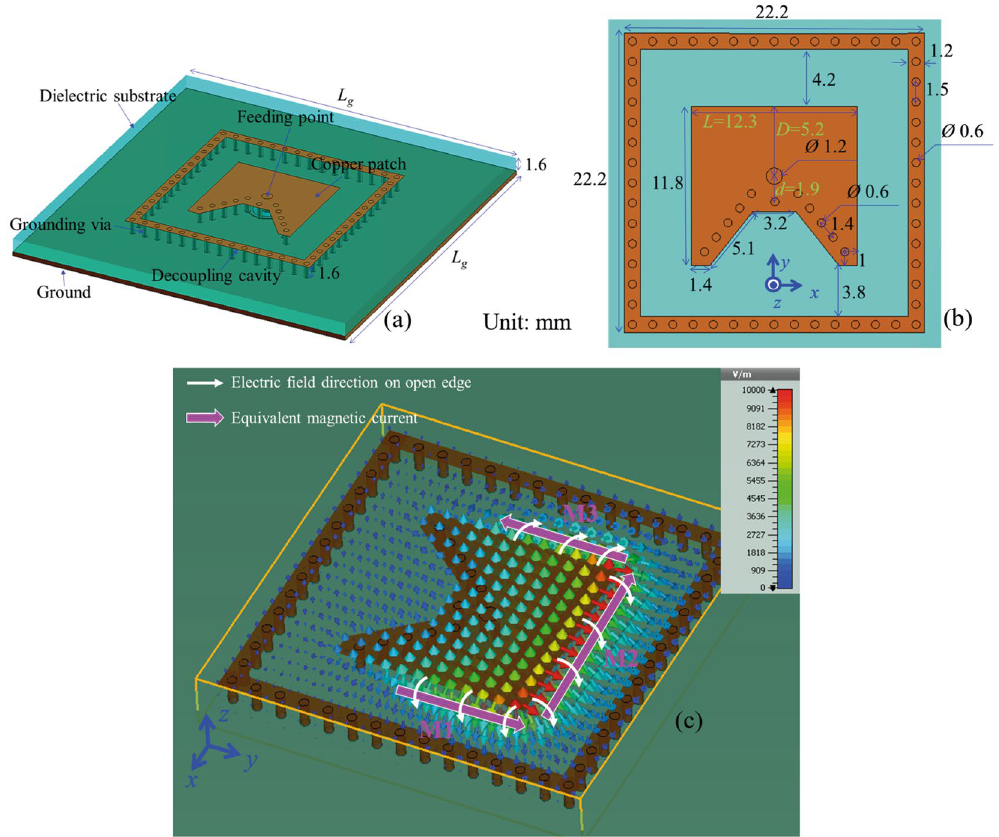
Figure 2. Geometry of the TMC antenna. ( a ) Perspective view and ( b ) partial enlarged detail. The color brown represents copper material and the color aquamarine represents dielectric substrate. ( c ) Electric field distribution. The directed equivalent magnetic currents have been marked in the figure. (Unit: